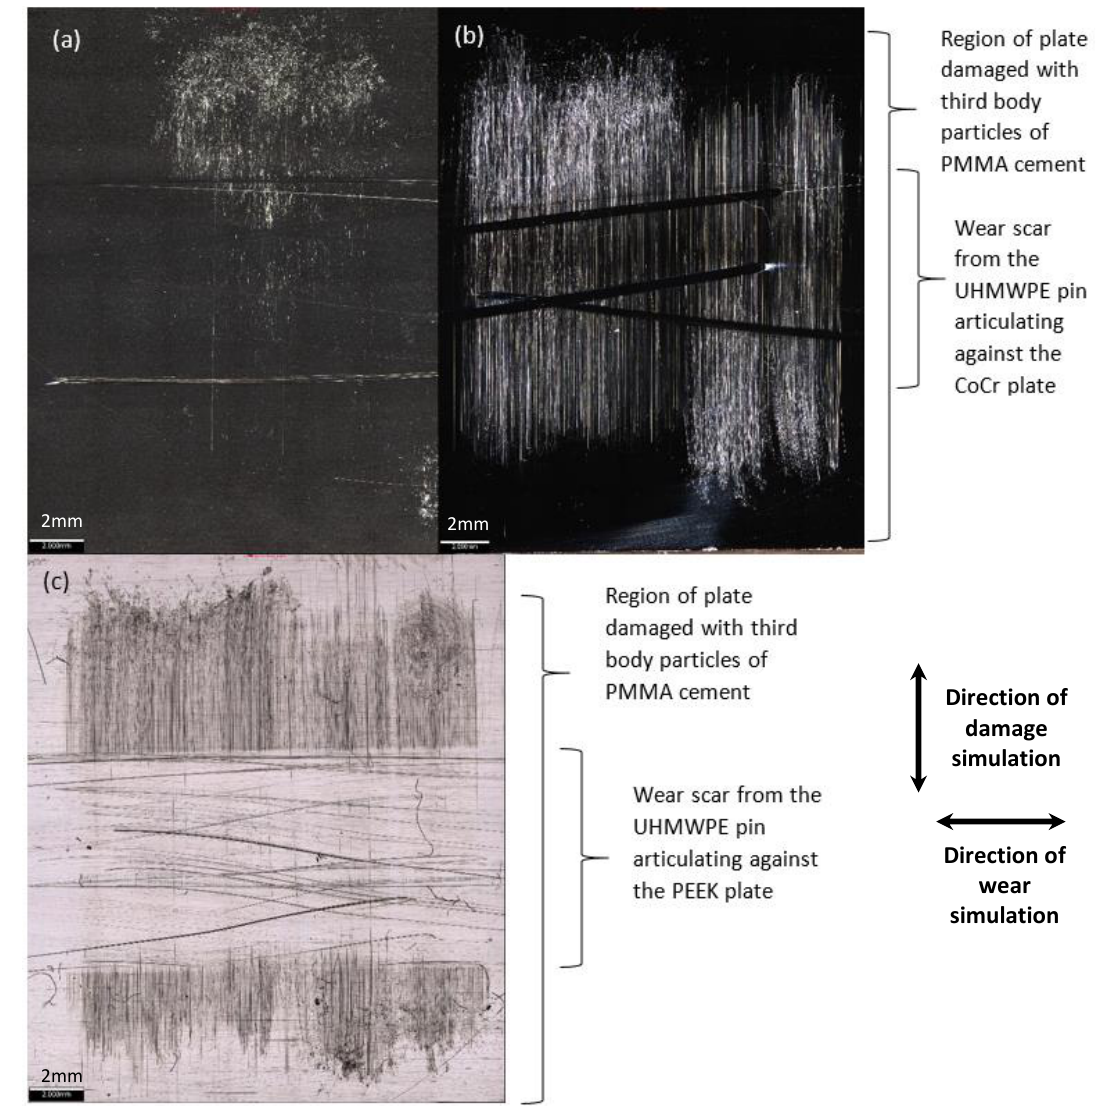
Figure 2. Representative images of the CoCr and PEEK plates following damage simulation with PMMA cement particles and wear simulation taken using an Alicona G5 IF with 5 × magnification. ( a , b ) CoCr plates. In ( b ), scratches caused by the PMMA cement particles are more clearly visible; in both images, isolated scratches from the wear simulation can be seen. ( c ) a PEEK plate. The polishing and scratching from the wear simulation is visible running perpendicular to the direction of damage simulation. Scale bars represent 2 mm, arrows denote directions of damage simulation and wear simulation.